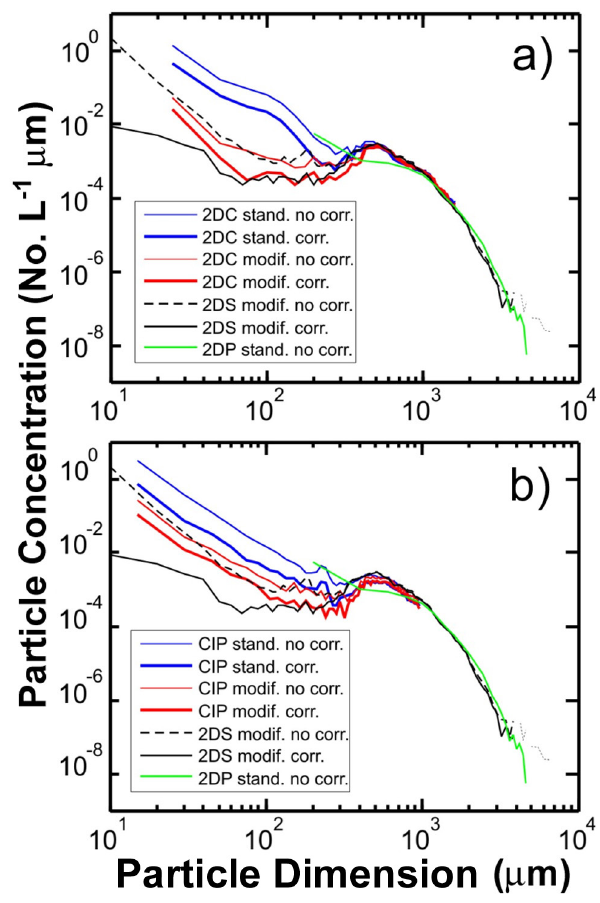
Fig. 8. Particle size distributions from 14:09:00–14:21:00 UTC, 8 April 2009, collected during the AIIE field project. Data are repro- duced from Korolev et al. (2010b) with the addition of 2D-S data for the same time period. “stand.” Means standard probe tips; “modif.” means modified probe tips, “corr.” means data have been adjusted using an arrival time algorithm and “no corr.” means that no arrival time algorithm has been